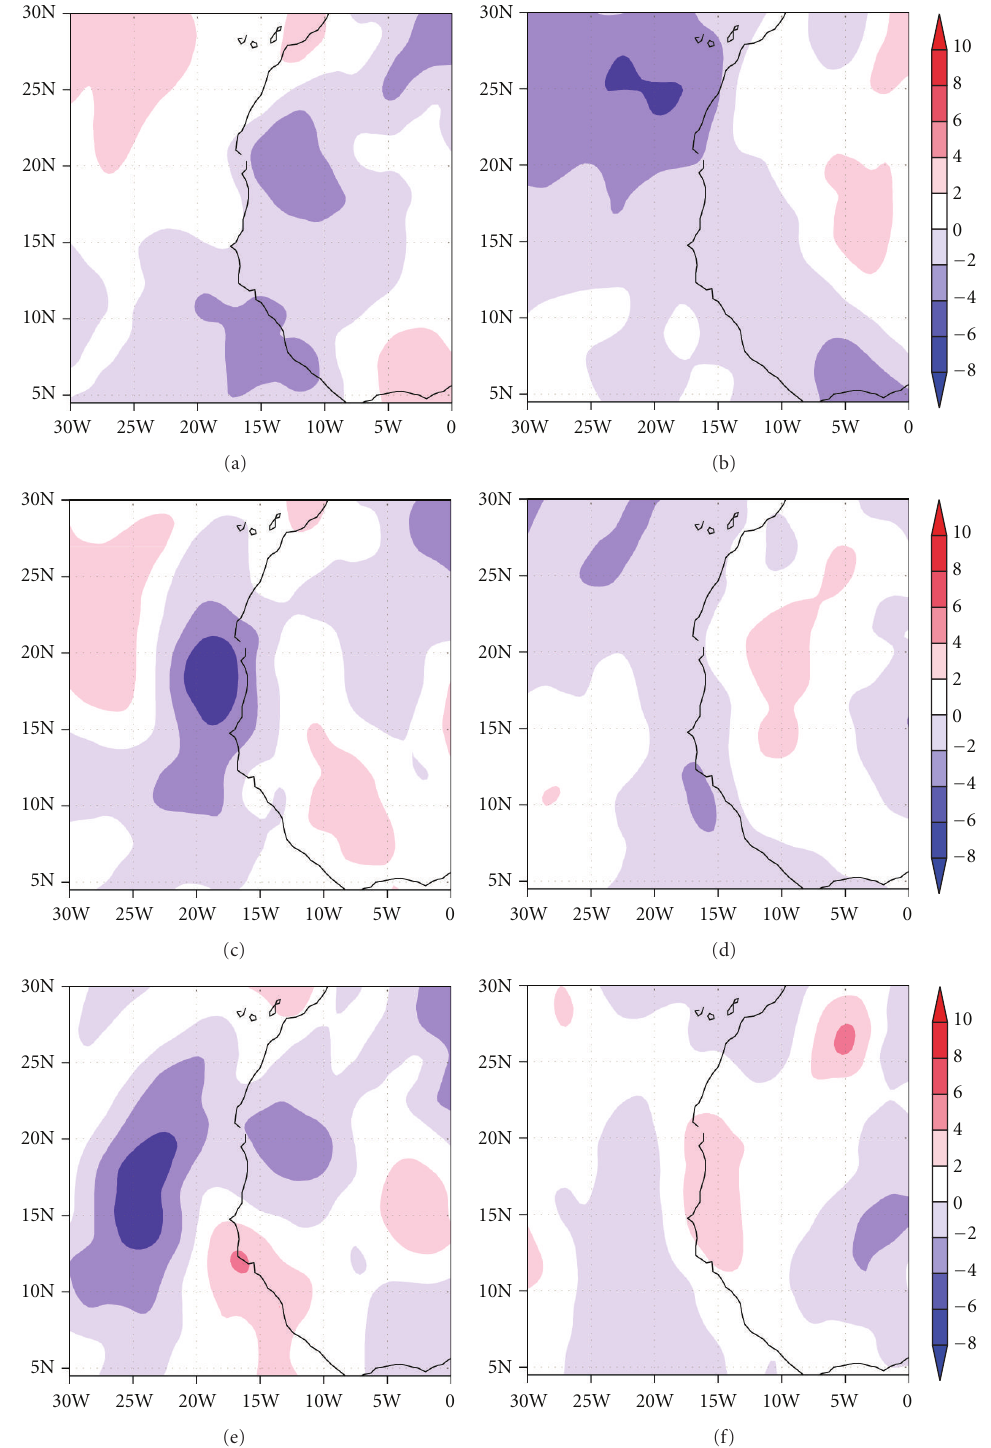
Figure 5: Similar to Figure 3 but for 700 hPa meridional wind anomalies. Darker blues indicate stronger southerly